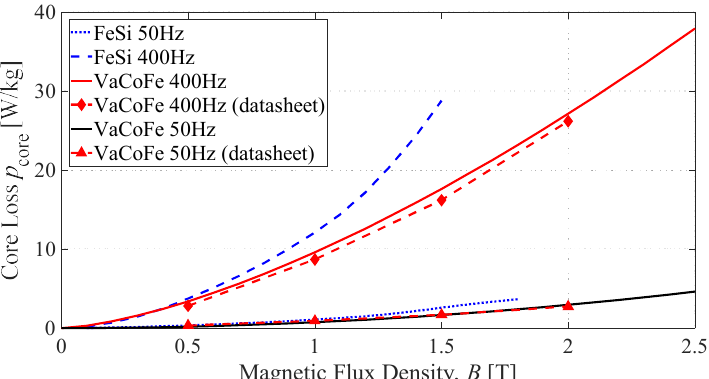
Figure 2. B-H curve of lamination materials: FeSi, VaCoFe obtained experimentally and from manufacturer’s datasheet.